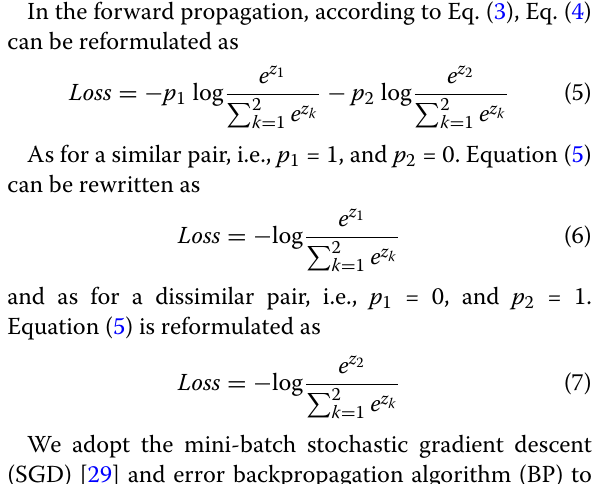
Fig. 1 The architecture of the siamese network, including two CNN models, one connection function and one fully connected (FC) layer